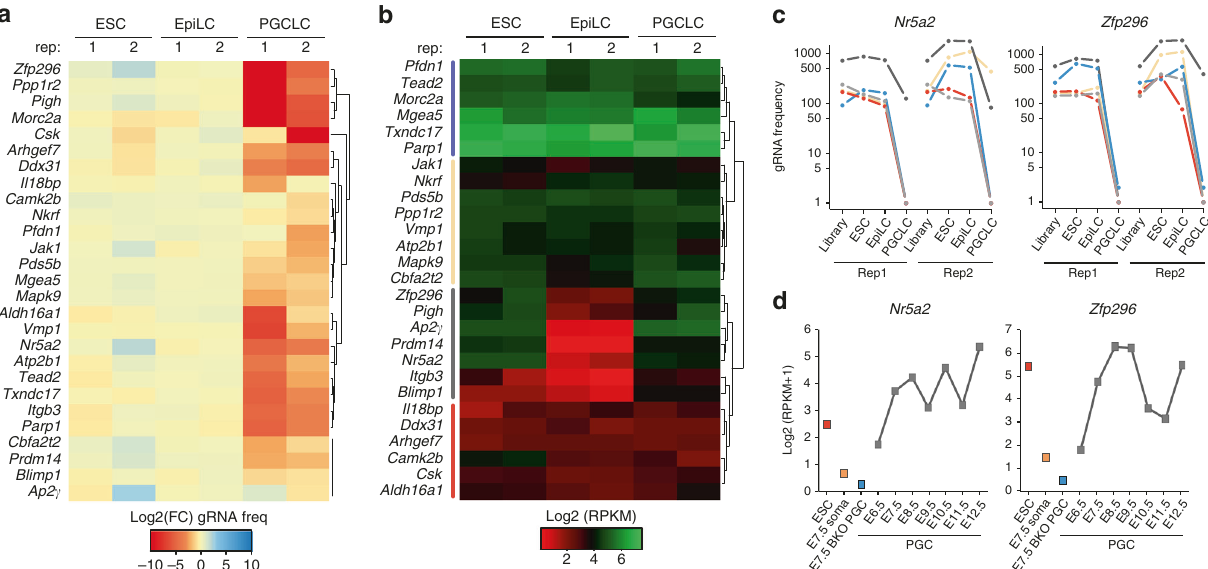
Fig. 3 Candidate genes for primordial germ cell fate. a Heatmap showing mean fold-change (FC) in normalised frequency of gRNAs that target candidate PGC regulators, relative to their frequency in the preceding cell state. b Log 2 RPKM gene expression dynamics of candidate PGC regulators during induction of SGET ESC into d6 PGCLC in the screen. c Normalised frequency of individual gRNAs targeting Nr5a2 and Zfp296 during induction of PGCLC. d Expression dynamics of Nr5a2 and Zfp296 during in vivo formation of PGCs by single-cell RNA-seq. Blimp1 − / − PGC (BKO) and soma are shown